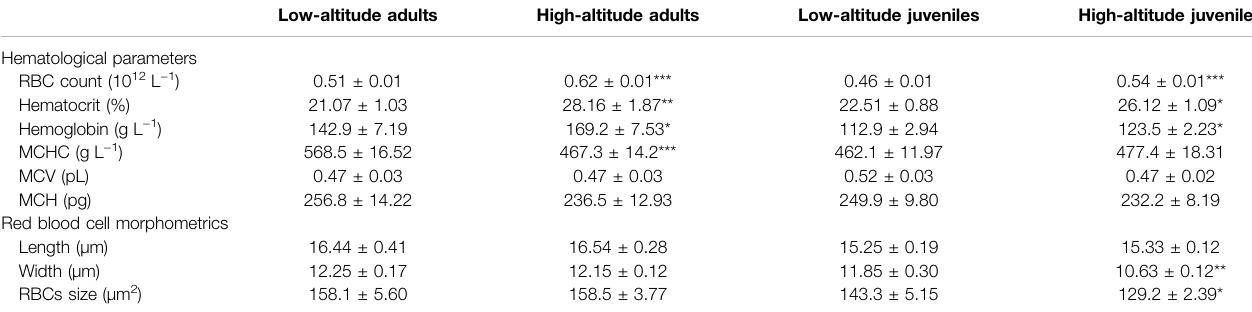
TABLE 2 | Hematological parameters and red blood cell morphometrics of high- and low-altitude adult and juvenile N. parkeri .